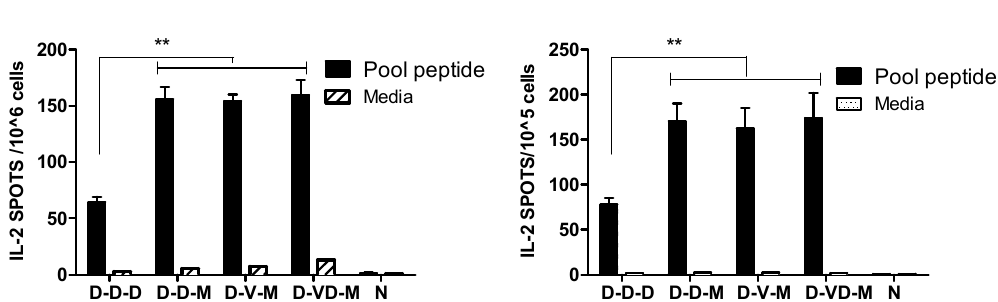
Figure 6. IL-2 secreting cell spots from spleen cells or from CD4 T cells plus DCs in vitro. ( A ) IL-2 secreting cell spots from spleen cell cultures. The levels of IL-2 secreting cell spots in spleen cell (1 × 10 6 ) cultures were determined by IL-2 cytokine ELISPOT after stimulation with a pool of peptides; ( B ) IL-2 secreting spots in CD4 T cells plus DC cultures. CD4 + T (1 × 10 5 ) cells (purified from spleen cells) in the presence of DCs (1 × 10 4 ) loaded with a pool of peptides were plated in 96 well ELISPOT plates coated with anti-IL-2 antibodies in triplicates. Spleen cells were collected at 14 days after second boost. Groups are the same as described in the Figure 2 legend. **: p < 0.001 between the comparing groups in the peptide pool after second boost.